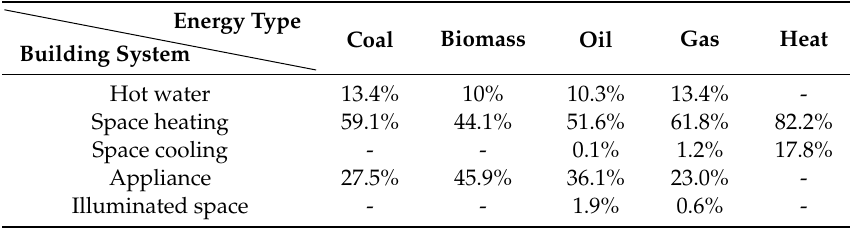
Table A6. The shares of flows from fuel and heat to building systems on global average.